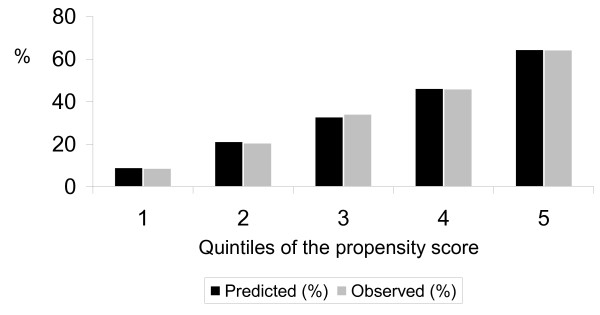
Mean predicted and observed probability of peritoneal dialysis assignment per quintile of the propensity score. Predicted (%): probability of assignment to peritoneal dialysis as predicted by the propensity score; Observed (%): actual prevalence of peritoneal dialysis assignment.